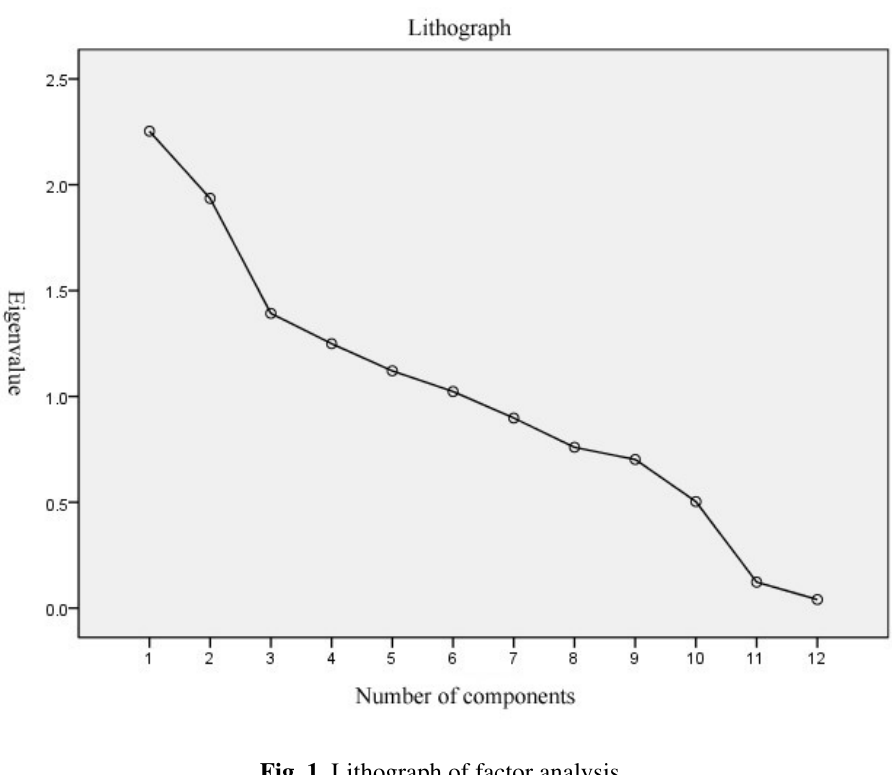
Fig. 1 Lithograph of factor